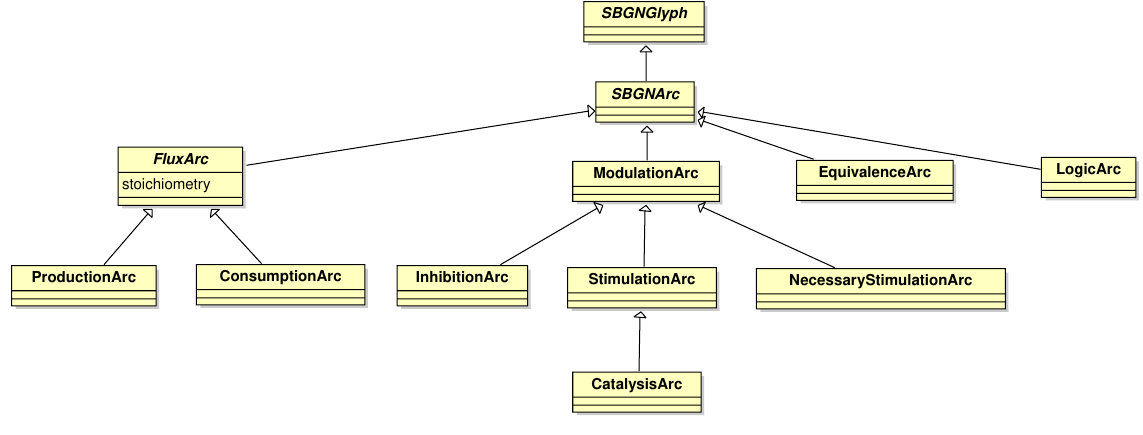
Figure 3.2: Organisation of the edge glyphs within SBGN Process Description language. All UML classes (boxes) correspond to Process Description node glyphs except those with italicised names, which are organisational groupings. They correspond to the groupings used elsewhere in this